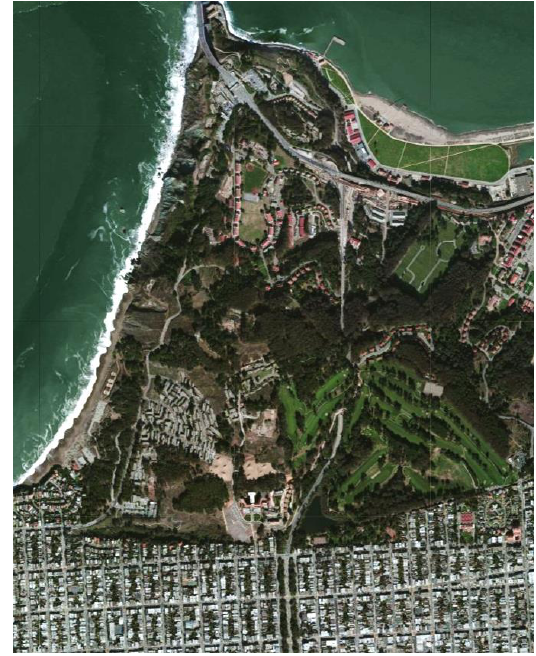
Figure 4: Color RGB orthophoto mosaic, Presidio in San Francisco, CA. Area shown is ~ 2.5 km by 3.0 km